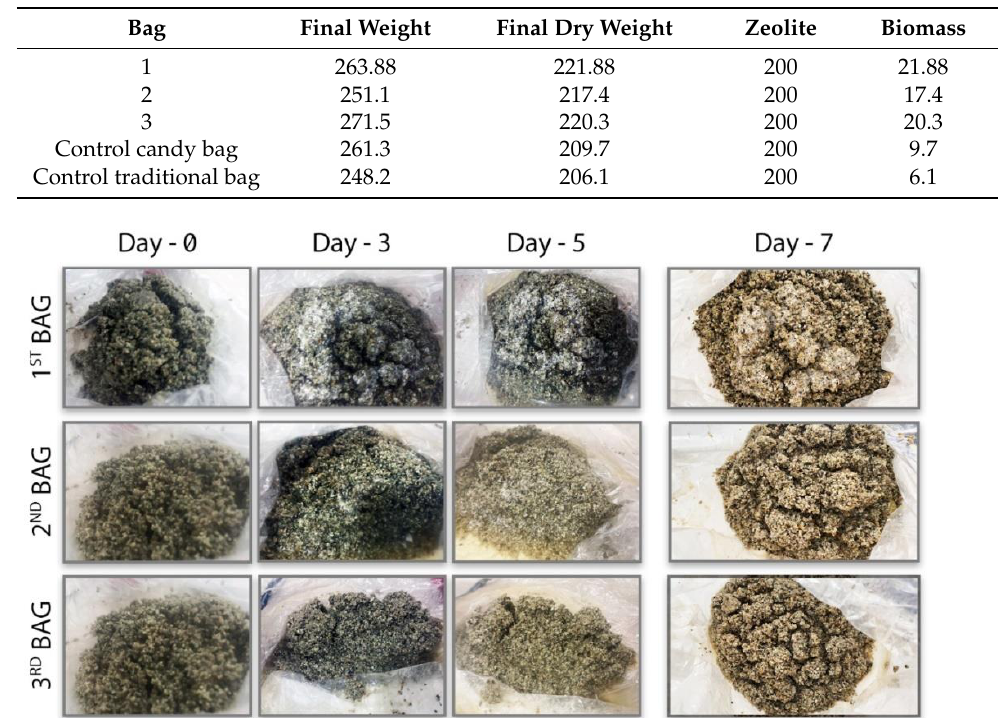
Table 4. MCB experiment biomass assay.